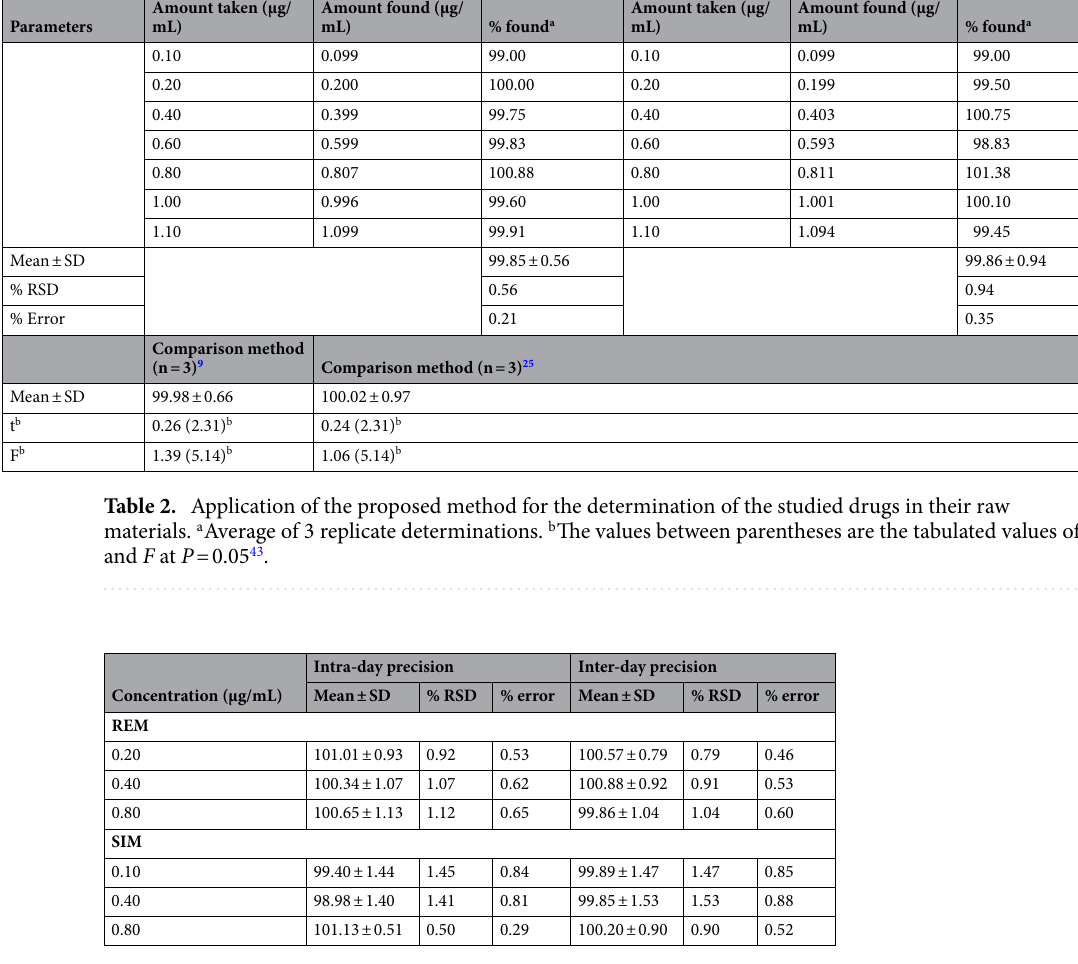
Table 3. Inter-day and intra-day precision data for the studied drugs using the proposed method.